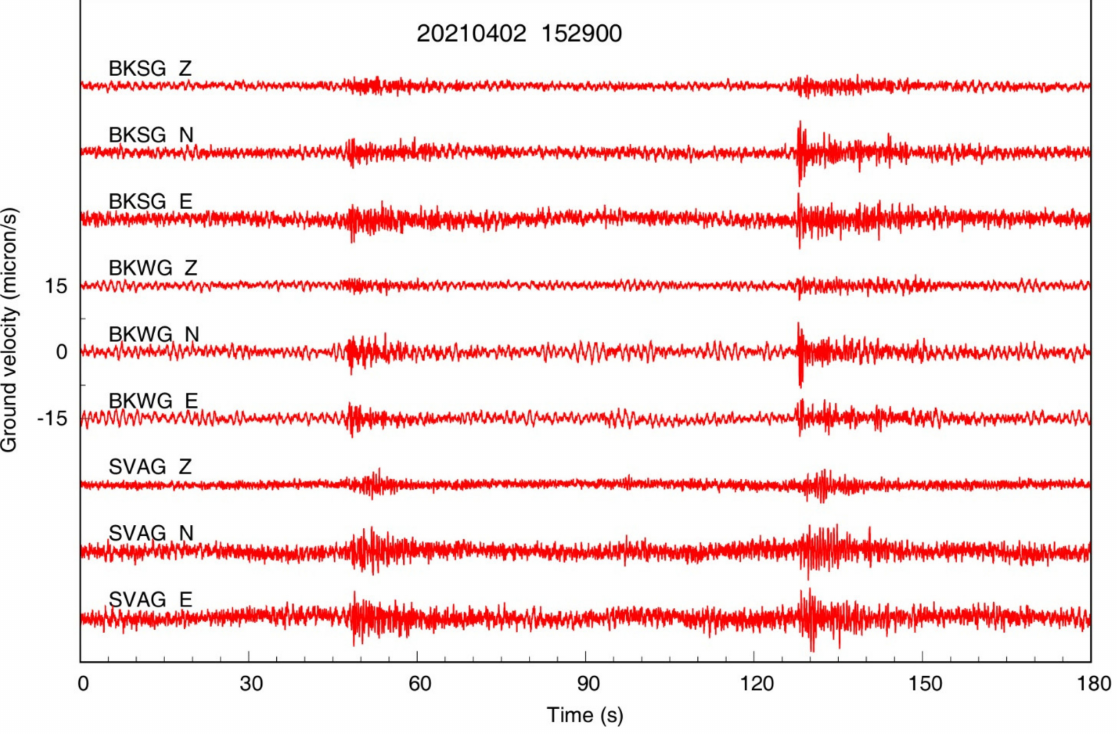
Figure 9. Two low-frequency earthquakes recorded at stations BKSG, BKWG and SVAG, characterized by very low signal to noise